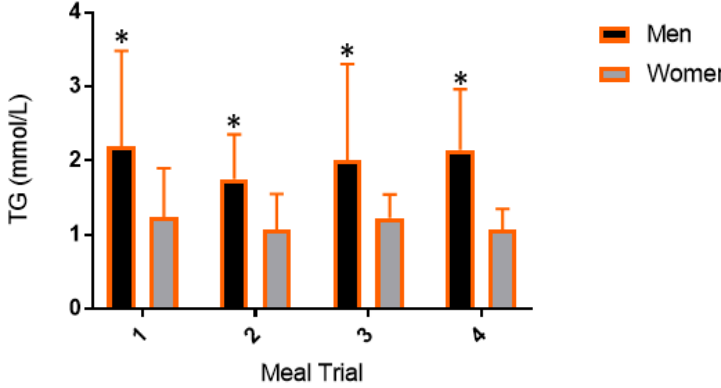
Figure 3. Peak response in triglycerides. Data are presented as mean ± SD. Peak TG responses for meal trials when stratified by sex. * Indicate differences between men and women for a specific meal trial ( p < 0.05). TG, triglycerides; B, butter; CoO, coconut oil; OO, olive oil; CaO, canola oil.